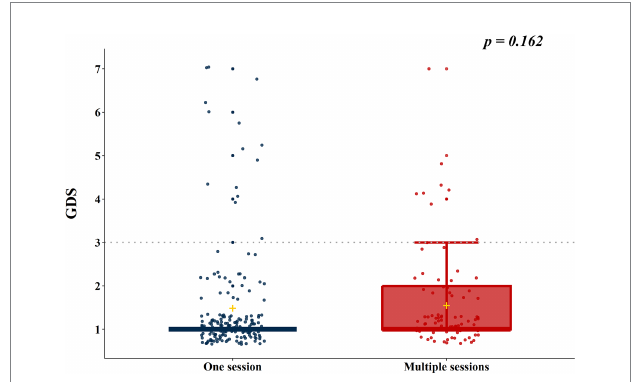
FIGURE 3 Neurocognitive outcome according to the number of hyperbaric oxygen therapy sessions in the total cohort. GDS, Global deterioration scale.